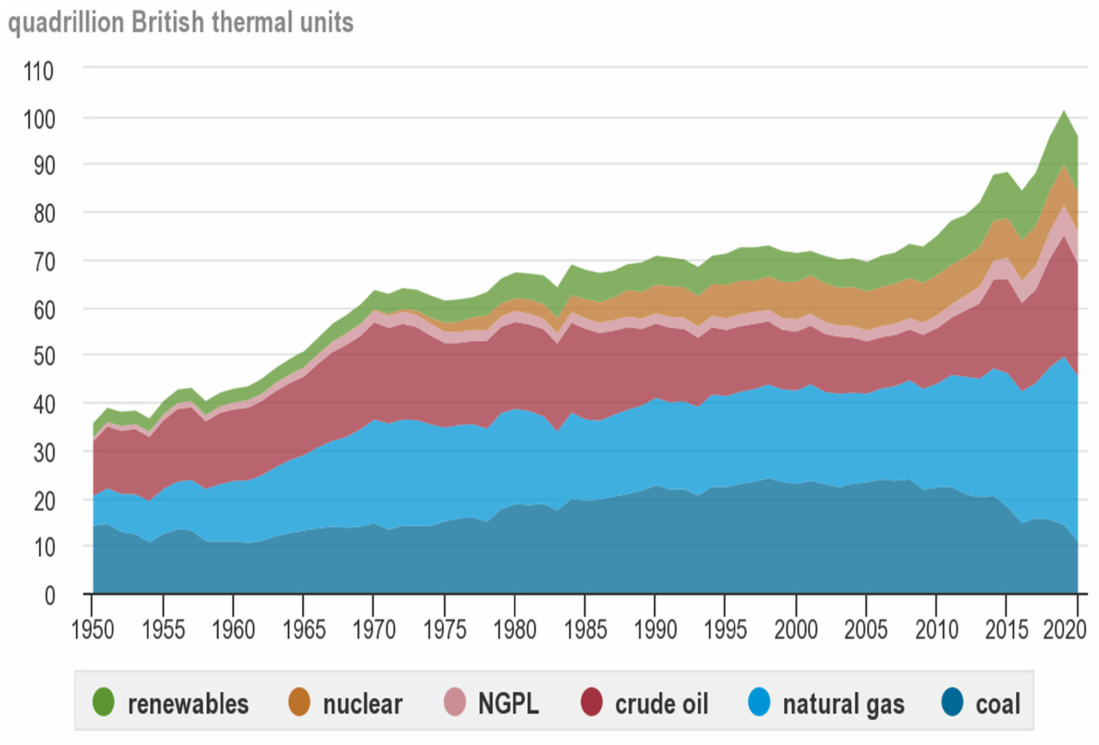
Figure 1. Energy consumption by sources.